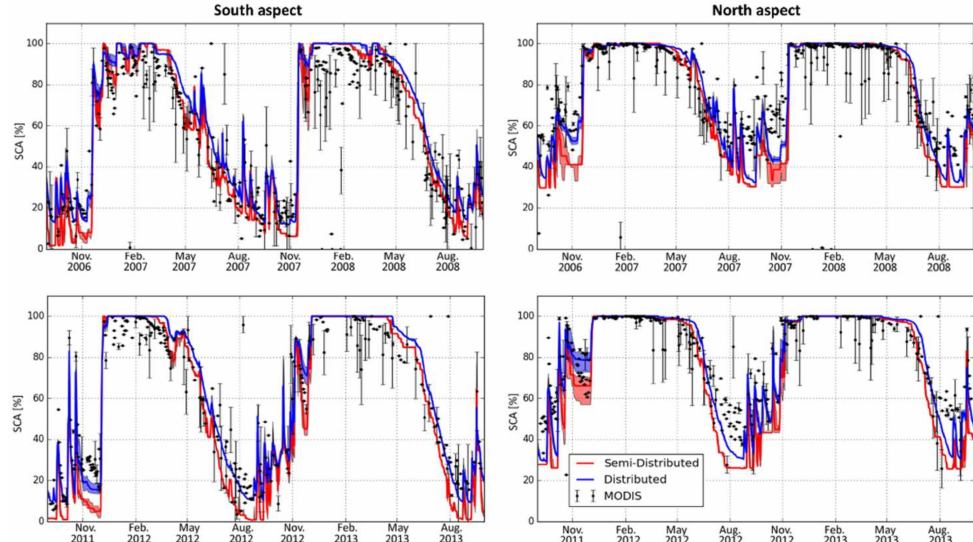
Figure 8. Evolution of the SCA in relation to north and south aspect for the 2006–2008 ( upper panel ; low level of snowpack accumulation) and 2011–2013 ( lower panel ; high level of snowpack accumulation) snow seasons. Vertical bars for the MODIS observations show the uncertainty associated with cloud presence for days having ≤ 20% snow cover. Red and blue shading for the distributed and semi-distributed SCA simulations show the uncertainty associated with various snow depth thresholds for determining whether a pixel was snow covered. The lower limit of the shading represents the SCA evolution for a 0.1 m threshold, the upper limit of the shading represents a 0.2 m snow depth threshold, and the middle line represents a 0.15 m snow depth